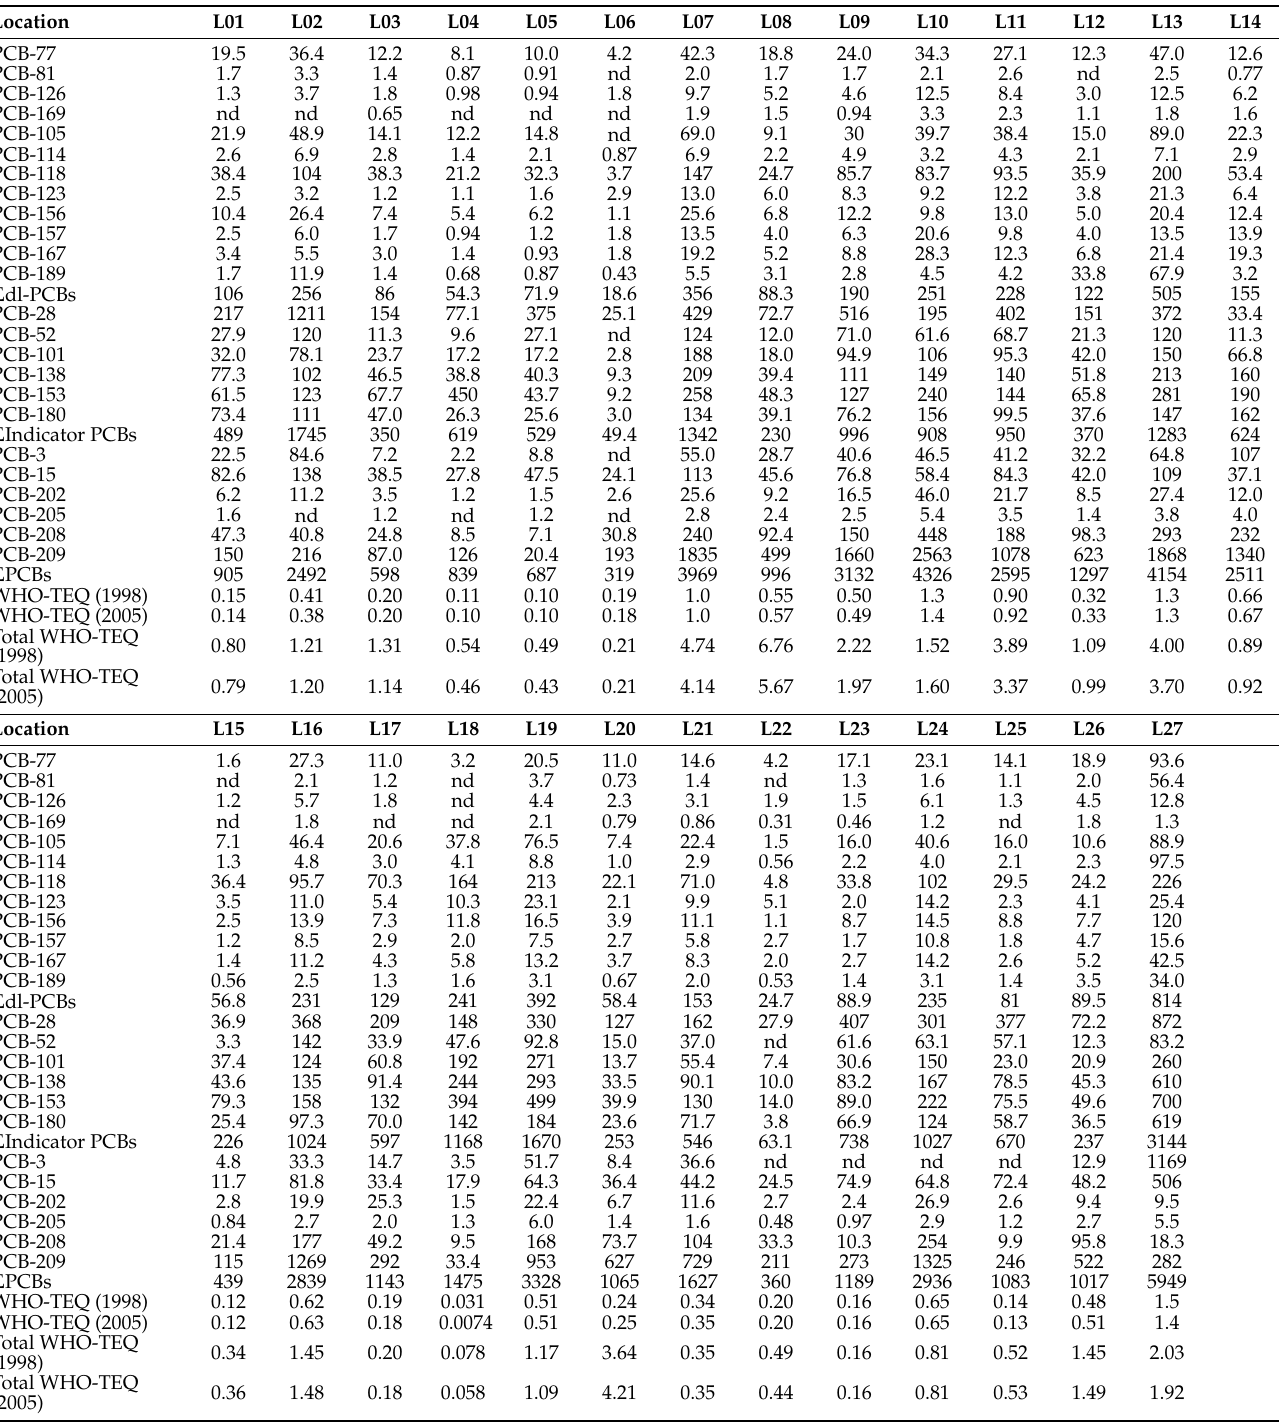
Table 2. Concentrations (pg g − 1 dw) of PCBs in the surface sediments from